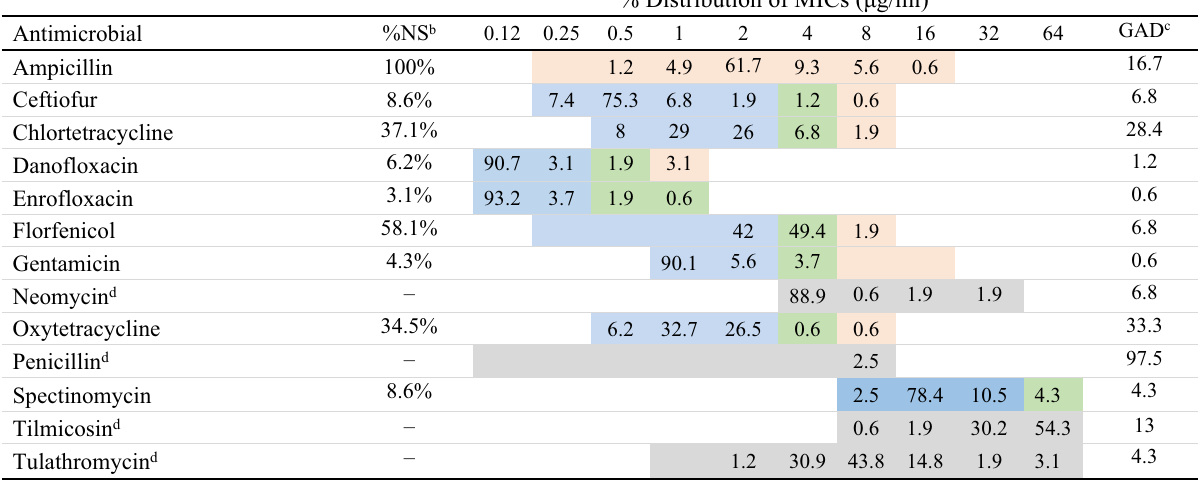
Table 3. Distribution of minimum inhibitory concentration (MIC) and resistance for intrauterine E. coli (n = 162) by individual drug for the BOPO6F panel. Highlighted areas in blue corresponds to susceptible, green corresponds to intermediate, and orange corresponds to resistant classification. For antimicrobials without a MIC breakpoint, the dilution scale tested is highlighted in gray. For the lowest MIC value in the dilution range, results indicate lowest MIC detected, but should be interpreted as less than or equal to ( ≤) the lowest MIC detected. a Distribution of minimum inhibitory concentration (MIC). b Percent of isolates classified as non-susceptible (Intermediate and Resistant) to the referred antimicrobial drug (%NS). c Percent of bacterial growth in all antimicrobial dilutions tested (GAD), Read as MIC > highest drug concentration available. d Enterobacterales are highly susceptible to these drugs or no CLSI breakpoint